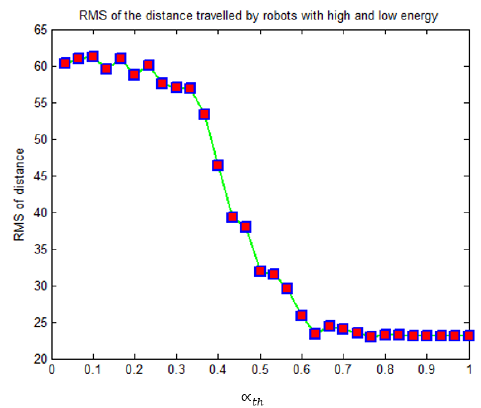
Figure 6. Root mean square value (RMS) of total travelled distance for different values of ∝ (cid:3047)(cid:3035) .